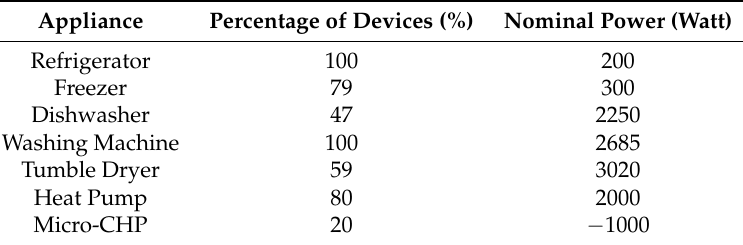
Table 2. Heterogeneous Virtual Power Plant Make-Up.